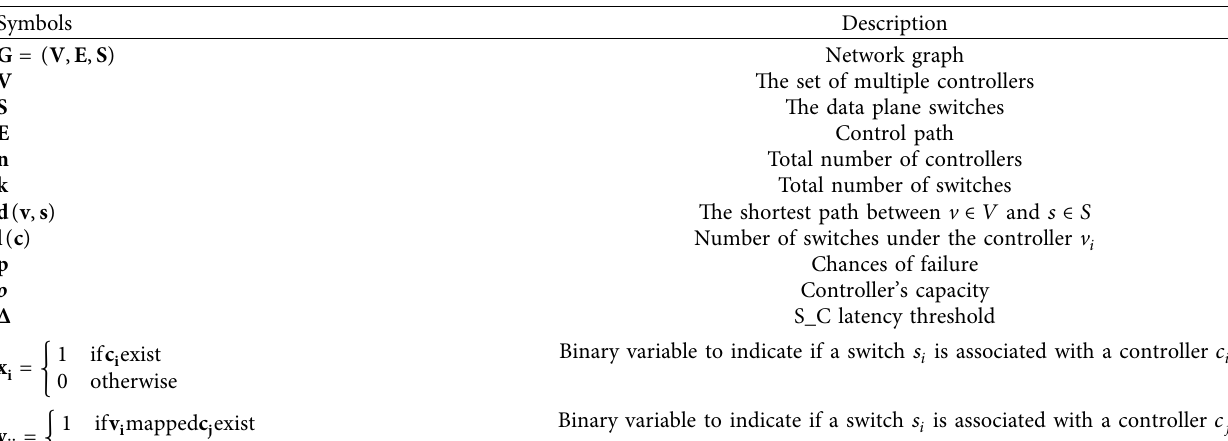
Table 6: Most commonly used CPP mathematical